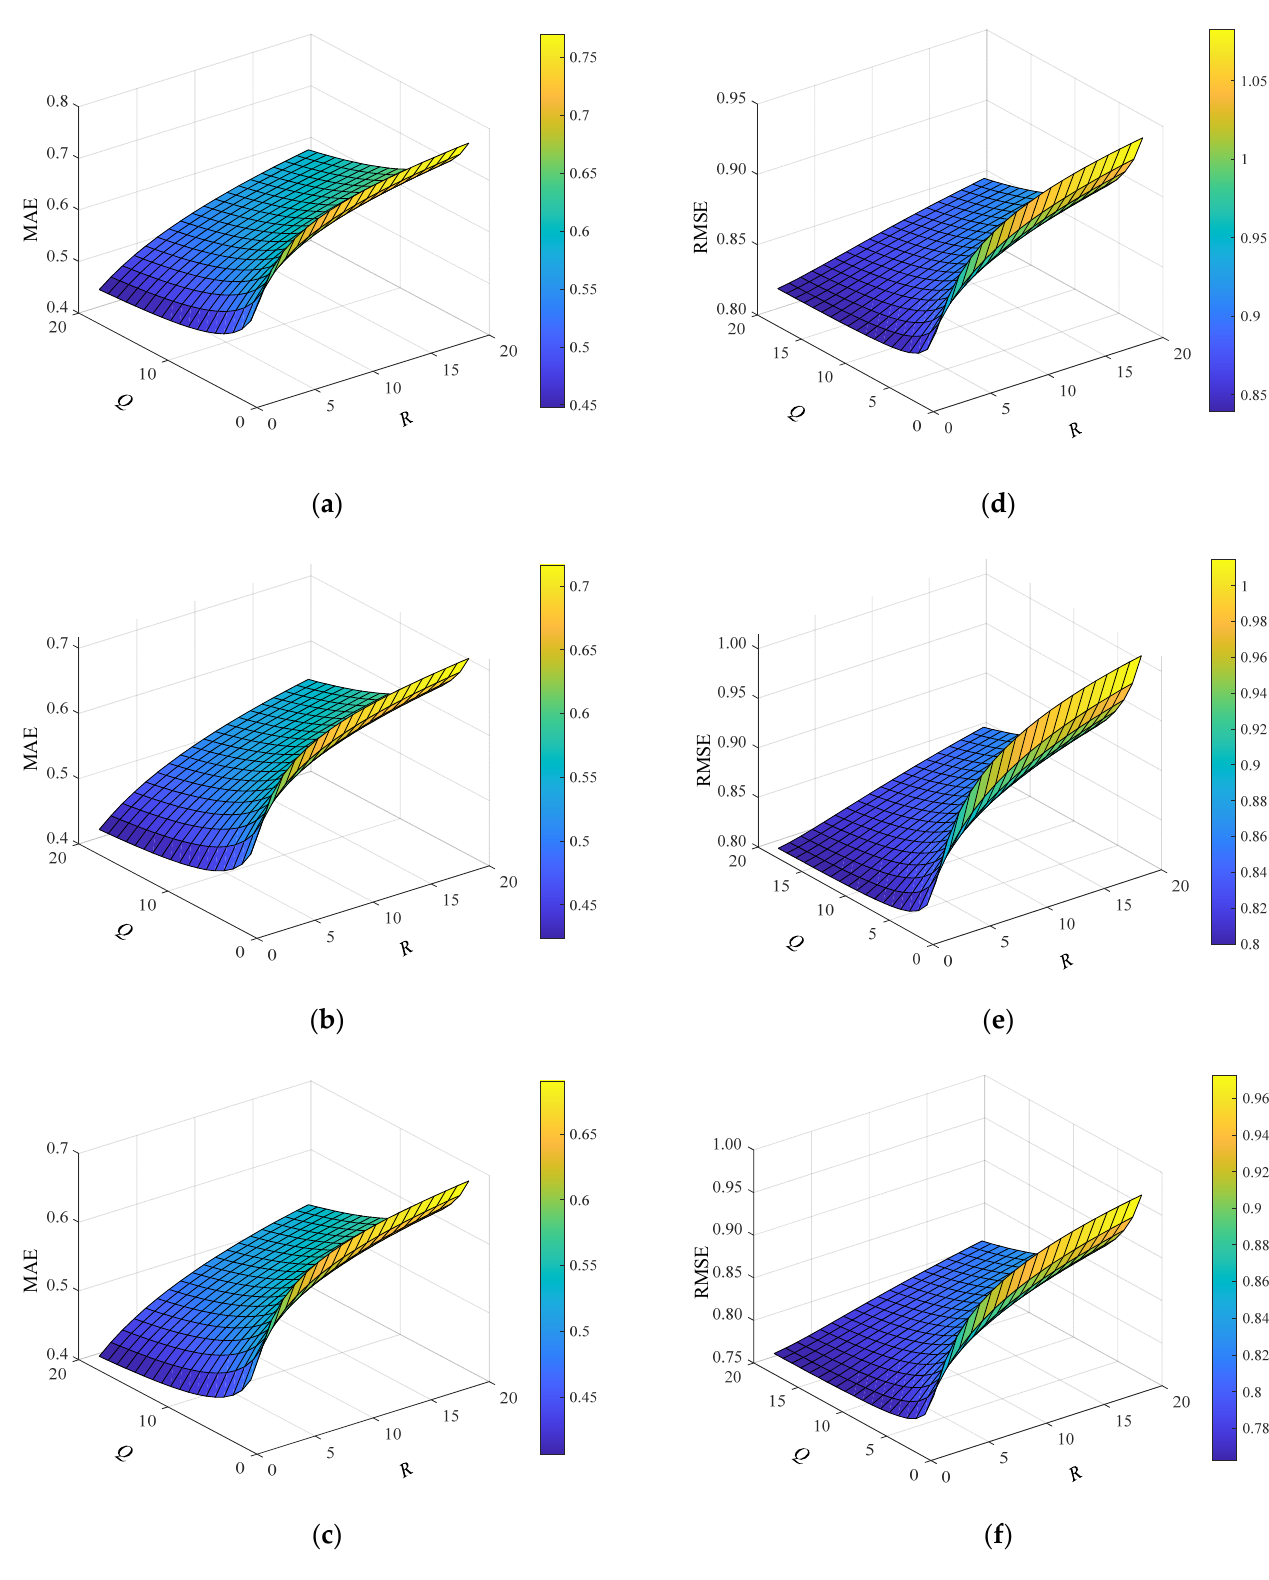
Figure 10. Experimental results of Kalman filter parameter variations. ( a ) Variation of MAE at tensor density of 0.1; ( b ) variation of MAE at tensor density of 0.3; ( c ) variation of MAE at tensor density of 0.5; ( d ) variation of PMSE at tensor density of 0.1; ( e ) variation of PMSE at tensor density of 0.3; ( f ) variation of PMSE at tensor density of 0.5.